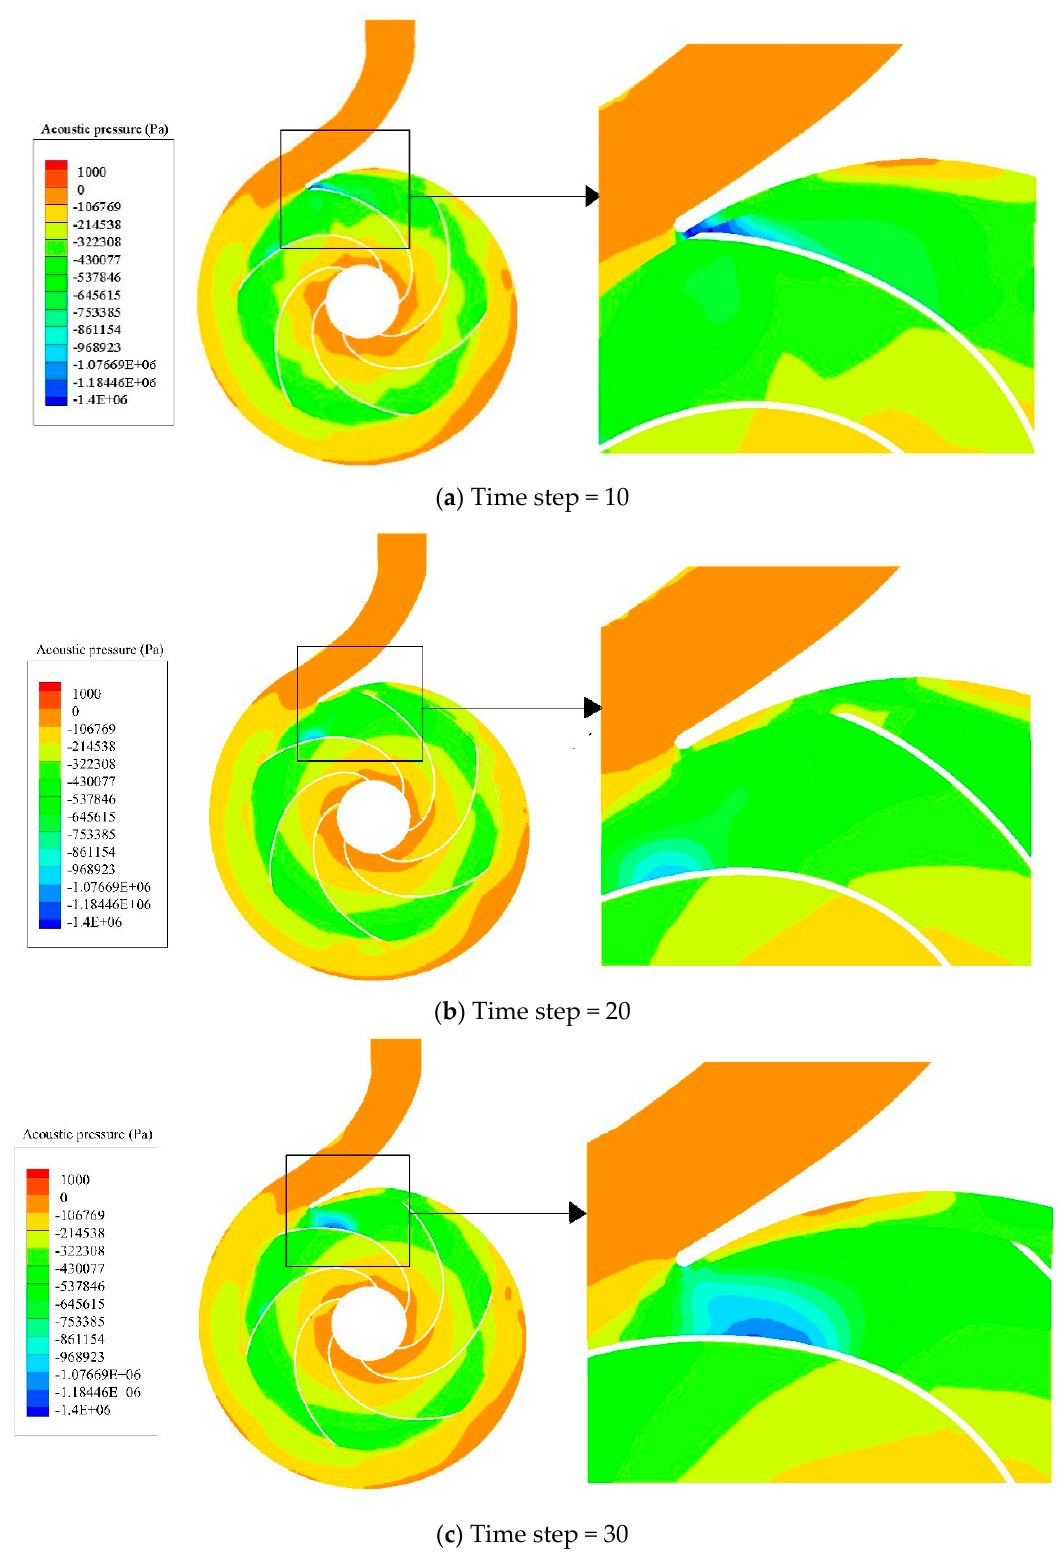
Figure 9. The distribution and evolution characteristics of acoustic pressure.